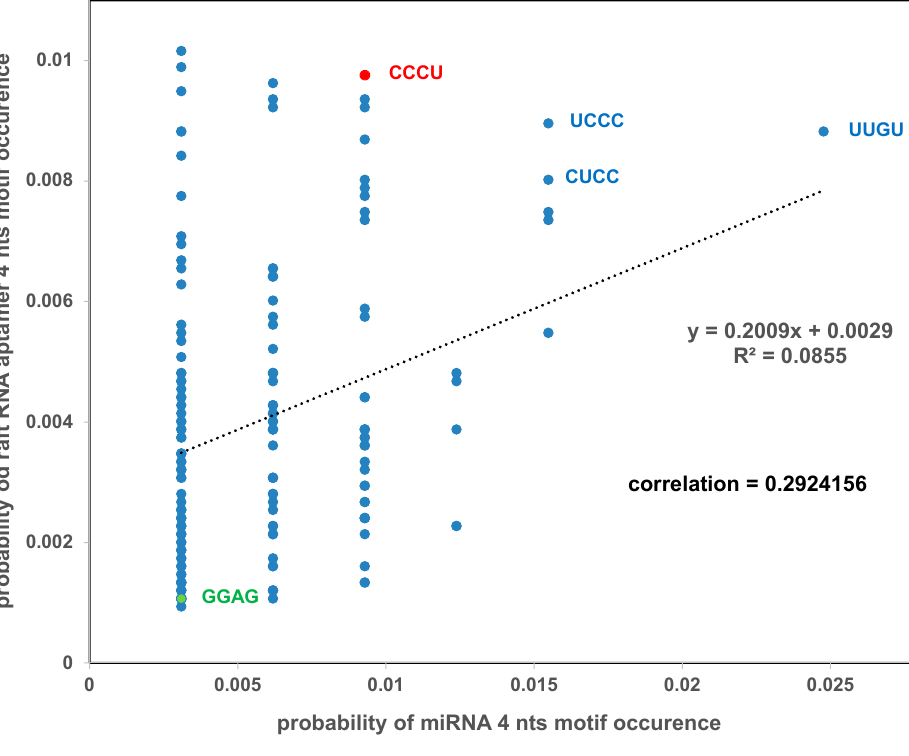
Figure 6. Correlation analysis of 4-nts motifs from two sets of RNAs: exosomal pro-tumoral miRNAs and raft RNA aptamers.